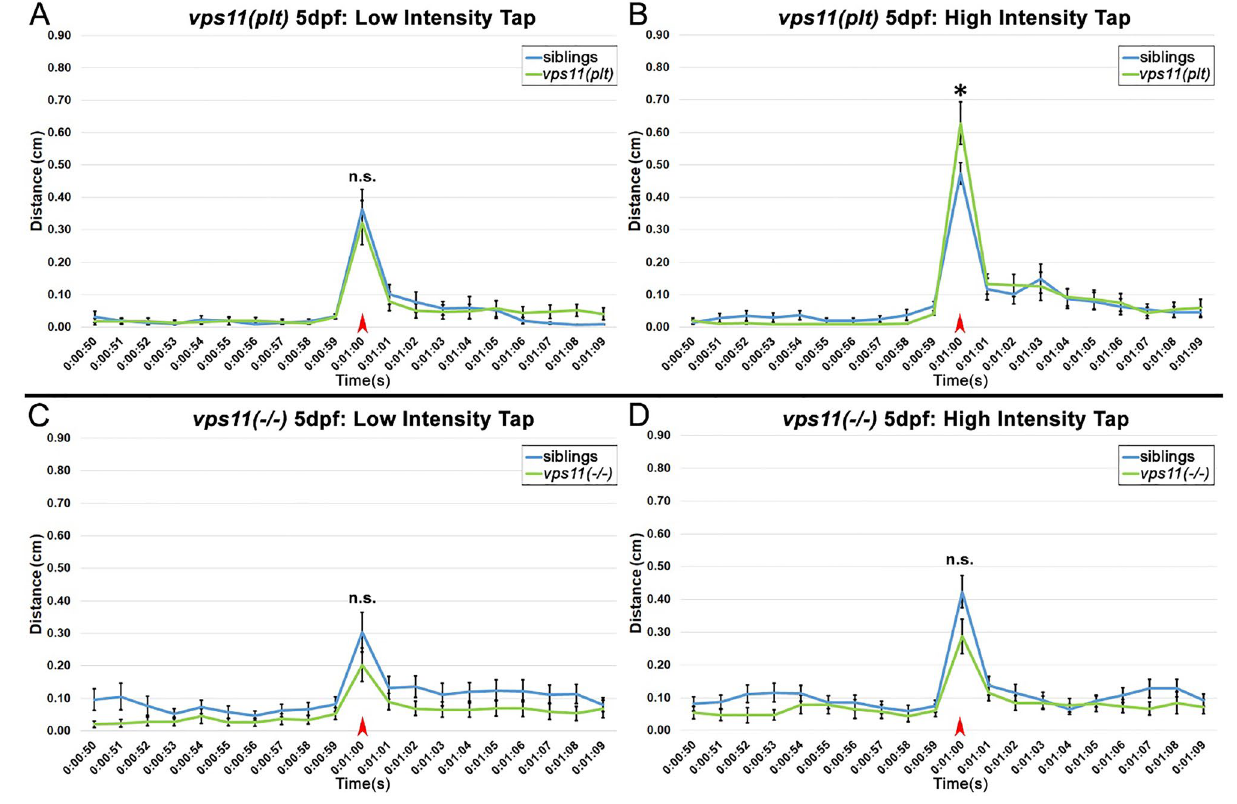
Figure 5. vps11(plt) and vps11 (−/−) mutants at 5dpf show normal distance travelled in response to both low and high intensity acoustic/tap stimuli. ( A – D ) Line graphs representing distance travelled by larvae at 5dpf before and after an acoustic/tap stimulus (red arrow). ( A ) Response of vps11(plt) (green; n = 55) and sibling larvae (blue; n = 61) to a low intensity stimulus. ( B ) Response of vps11(plt) (green; n = 63) and sibling larvae (blue; n = 67) to a high intensity stimulus. ( C ) Response of vps11 (−/−) (green; n = 59) and sibling larvae (blue; n = 60) to a low intensity stimulus. ( D ) Response of vps11 (−/−) (green; n = 57) and sibling larvae (blue; n = 60) to a high intensity stimulus. Error bars indicate